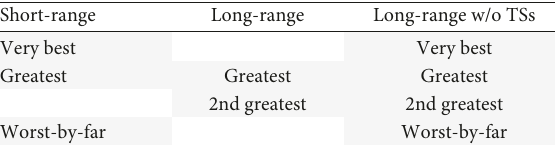
Table 18: Tabular representation of Rule